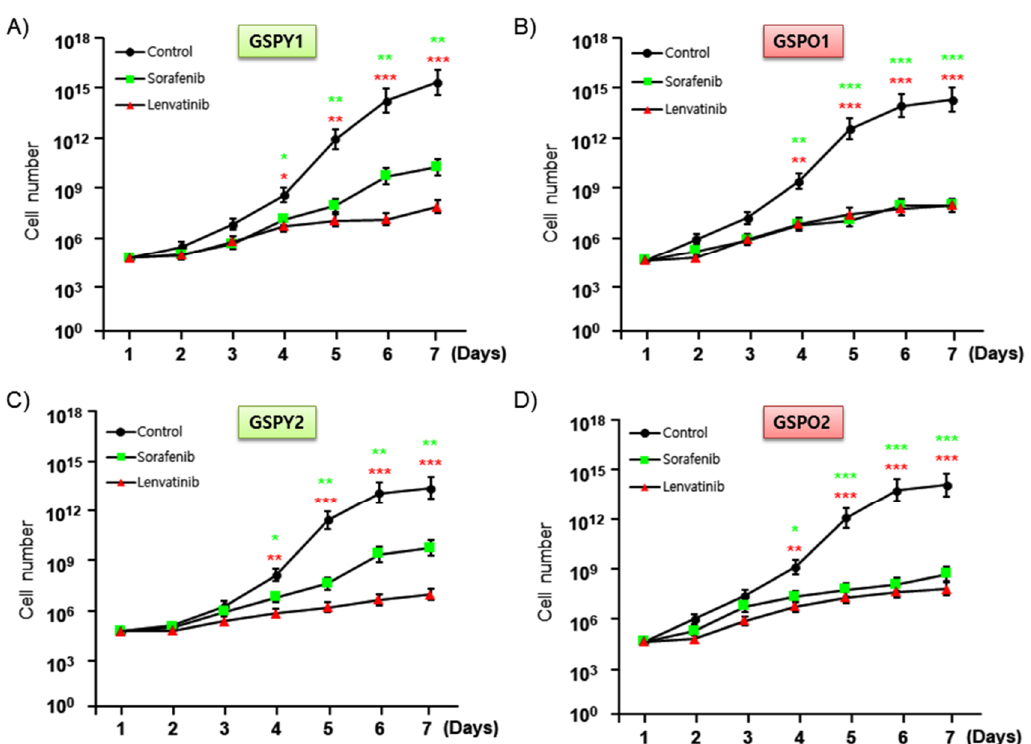
Figure 2. Anti-cancer effects of lenvatinib or sorafenib on patient-derived papillary thyroid cancer cells from young (GSPY) and older (GSPO) patients. Cell proliferation assay after treatments with lenvatinib or sorafenib alone: ( A , C ) GSPY; ( B , D ) GSPO. The data points were calculated as mean % of the value observed in the solvent-treated control. All experiments were repeated at least 3 times. Data are represented as means ± SD. * p < 0.05, ** p < 0.01, and *** p < 0.005 compared with control.